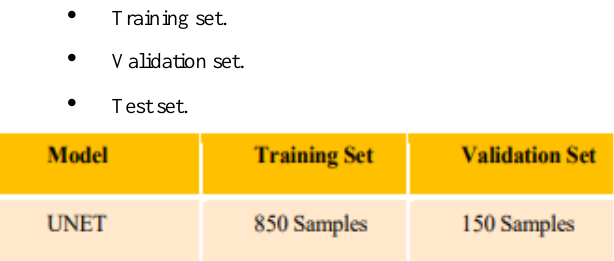
Tab.2: The training and validation set.